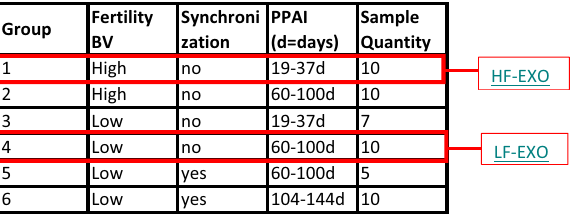
Table 1. Classification of 52 dairy cows into 6 different groups by fertility breeding value (BV), ovulation synchronization and postpartum anovulatory intervals (PPAI).